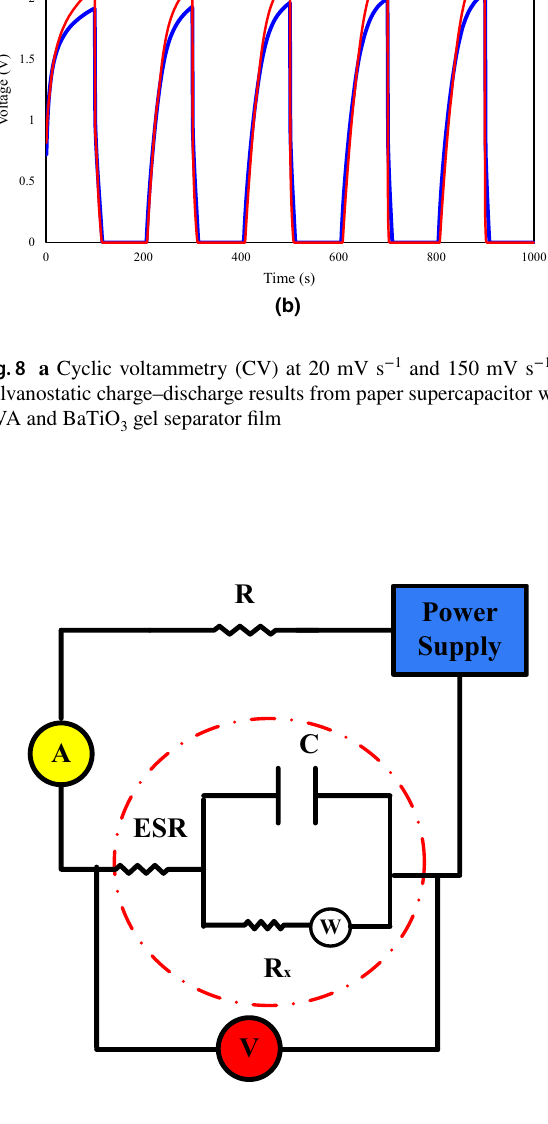
Fig. 9 Schematic of equivalent circuit of the paper